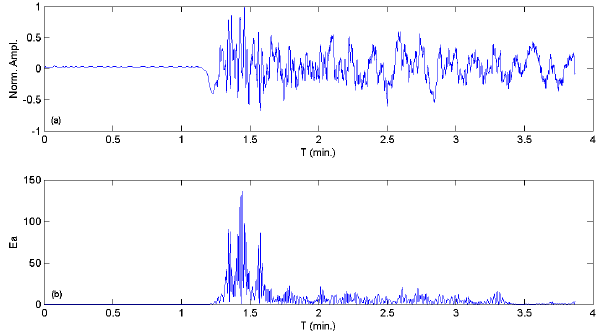
Fig. 5. (a) Seismogram of P-wave train; (b) Ea variation for Car Nicobar earthquake (24 July 2005).